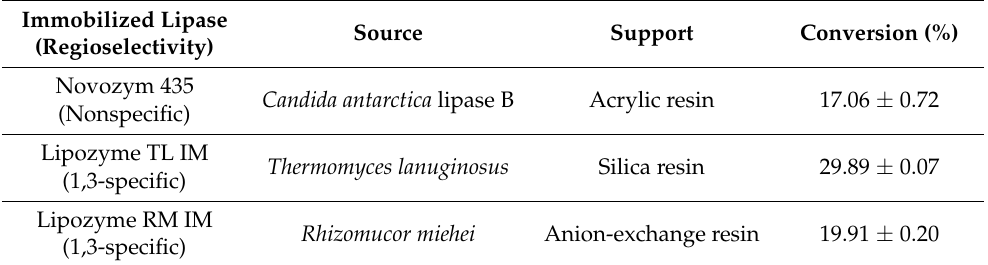
Table 2. Information on immobilized lipase and the corresponding conversion rate of naringin acetate. Immobilized Lipase Source Support (Regioselectivity)